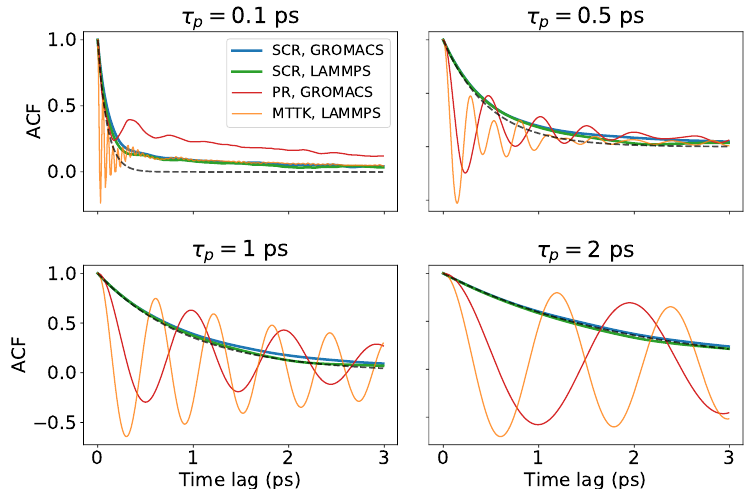
Figure 7. Results for crystal ice I h simulated with GROMACS and LAMMPS. Autocorrelation functions of the volume for different algorithms and codes, obtained with different choices of τ P , as indicated. The dashed lines represent the expected decaying functions exp